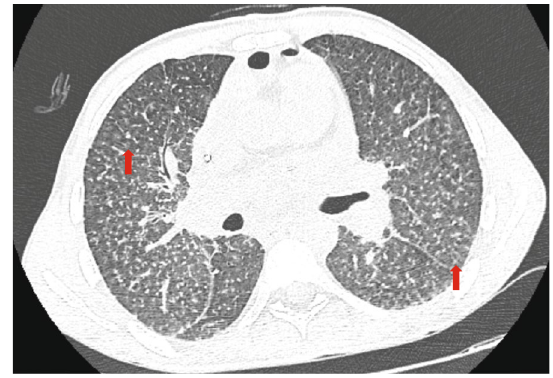
Fig. 2 High-resolution chest tomography showing bilateral centrilobular micronodules (red